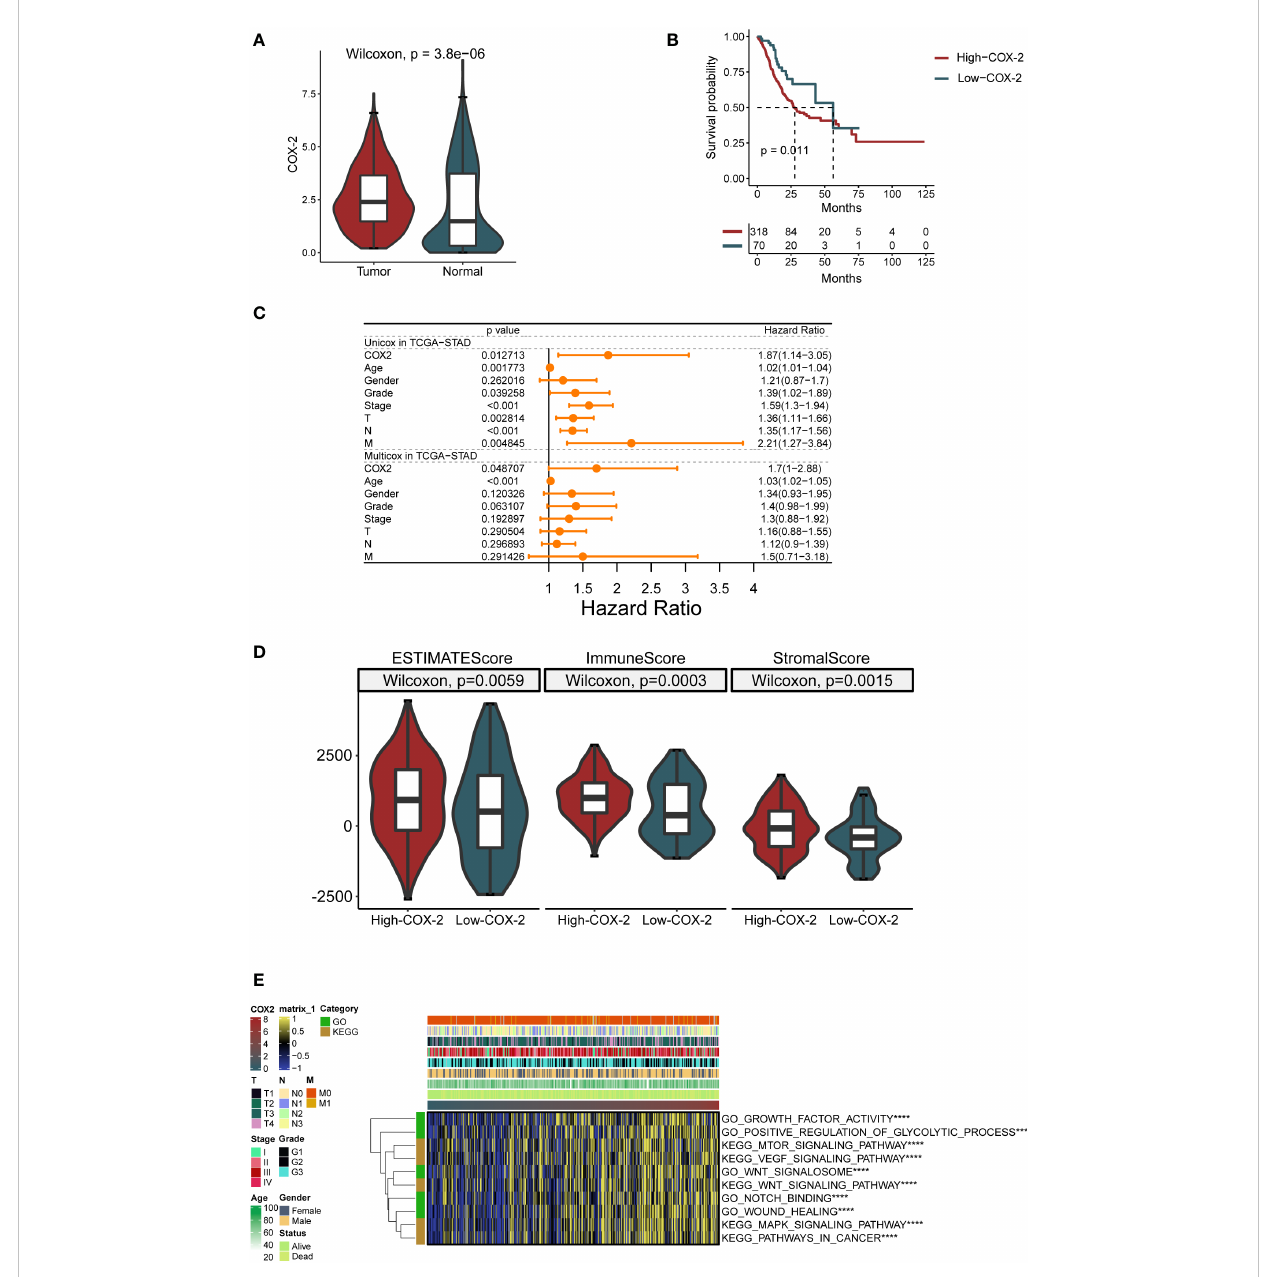
FIGURE 2 COX-2 is correlated with GC progression and prognosis. (A) Difference of COX-2 expression between cancer and paracancerous samples in TCGA database. (B) The survival curve of patients with high and low COX-2 expression based on TCGA database. (C) Forest map of univariate and multivariate cox regression based on TCGA dataset and clinical variables. (D) In gastric cancer tumor microenvironment, the expression of COX-2 is related to ESTIMATE score, immune cell in fi ltration (ImmuneScore) and the proportion of stromal cells (StromalScore). (E) The GSVA analysis of tumor-associated functions and signaling pathways in GO and KEGG